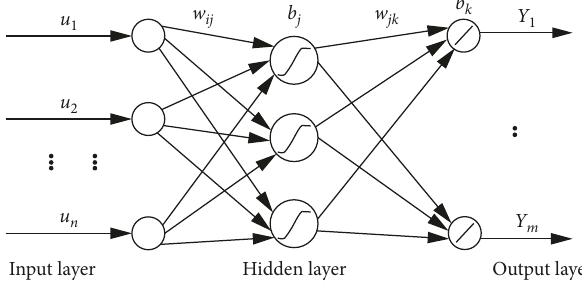
Figure 10: Calculation diagram of BP neural network